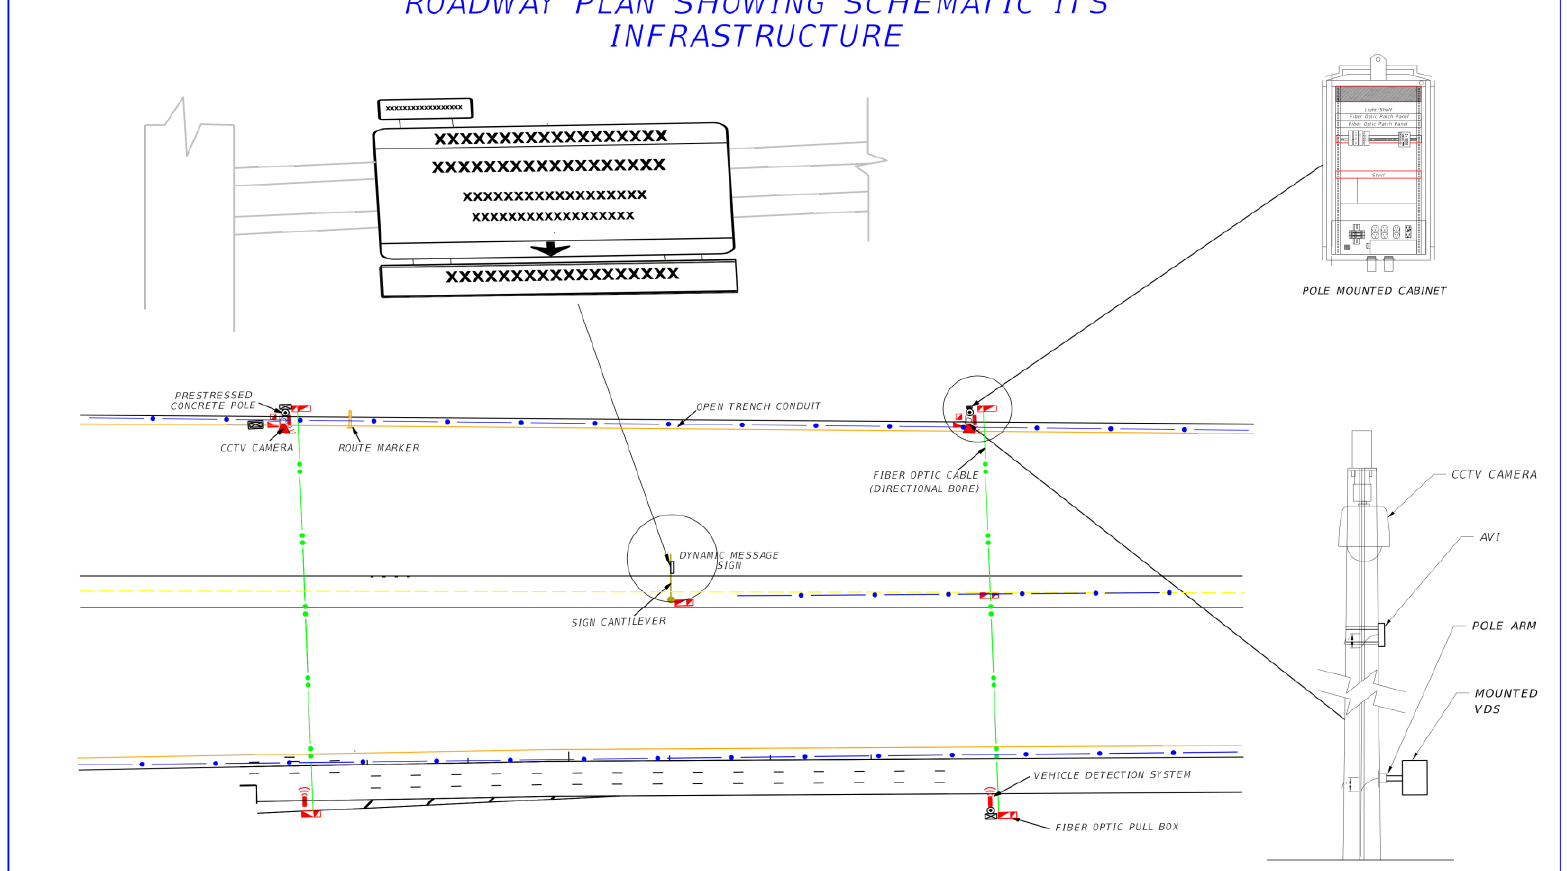
Figure 2. Schematic representation of the ITS infrastructure on the roadway.